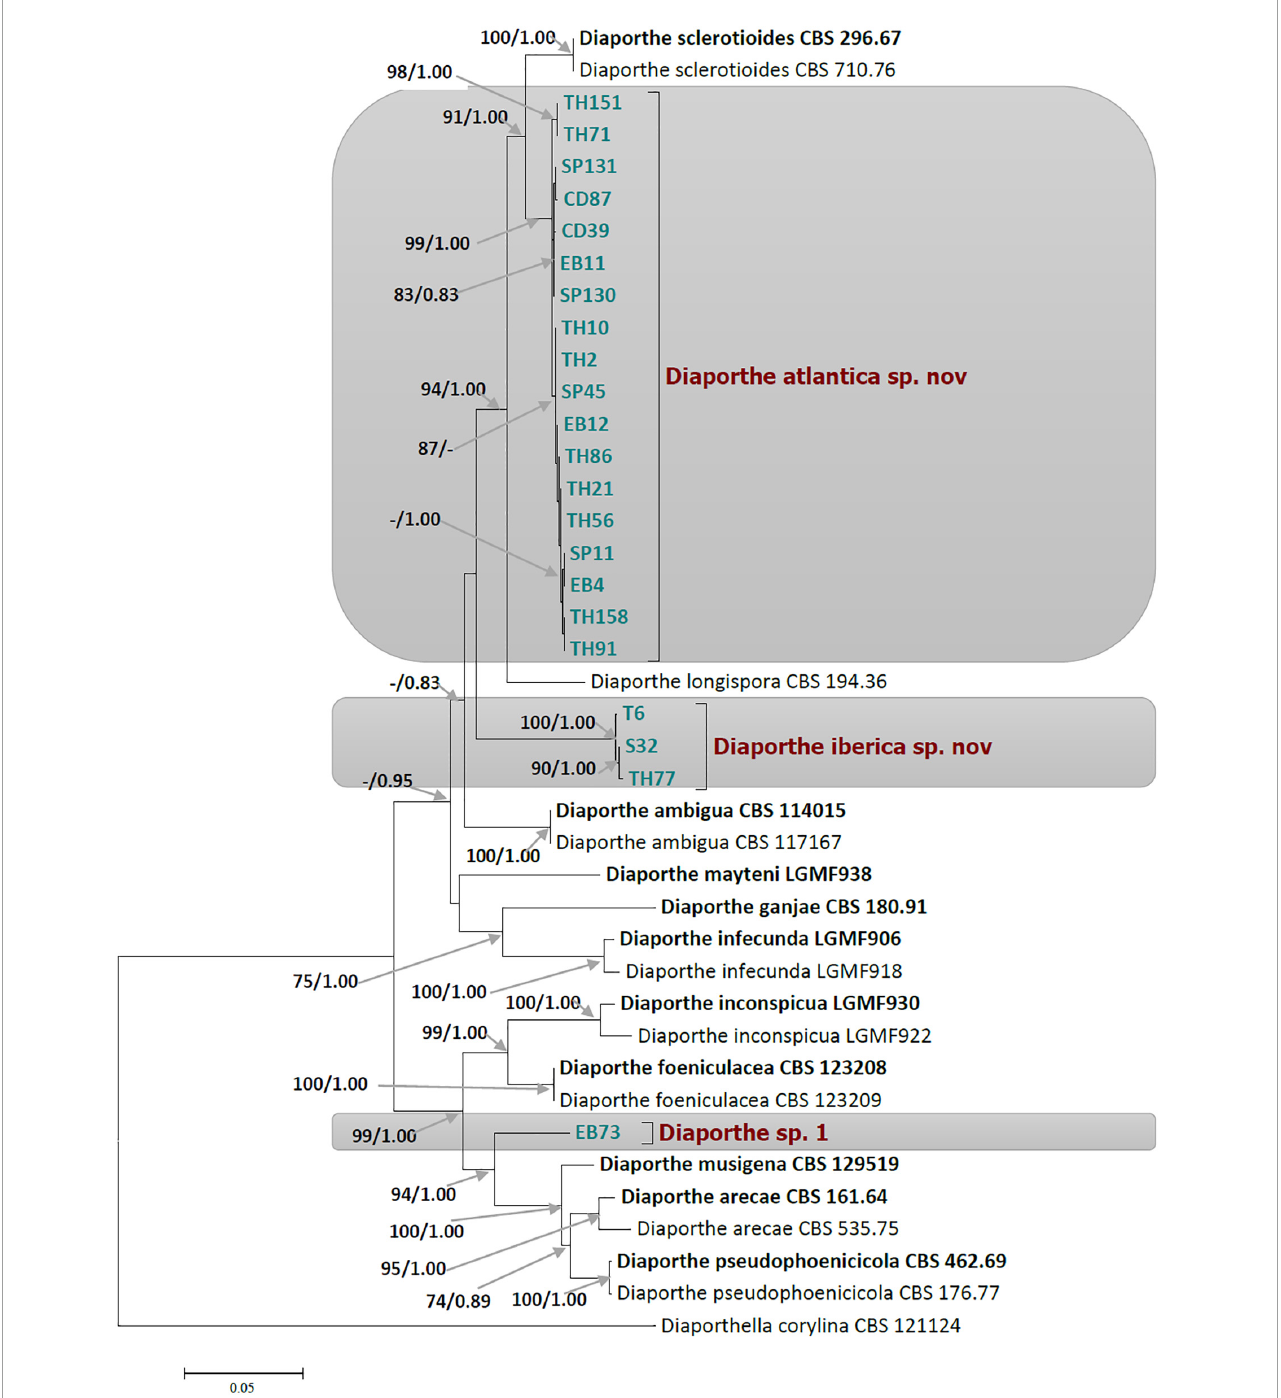
FIGURE1 Phylogram of Diaporthe resulting from a maximum likelihood analysis based on a combined matrix of ITS, TUB , CAL , TEF1 , and HIS3 . Numbers above the branches indicate ML bootstraps (left, ML BS ≥ 70%) and Bayesian Posterior Probabilities (right, PP ≥ 0.8). The tree is rooted with Diaporthella corylina. Isolates from present study are marked in colors. The scale bar represents the expected changes per site. The ex-type strains are Bold and strains from this study in green.